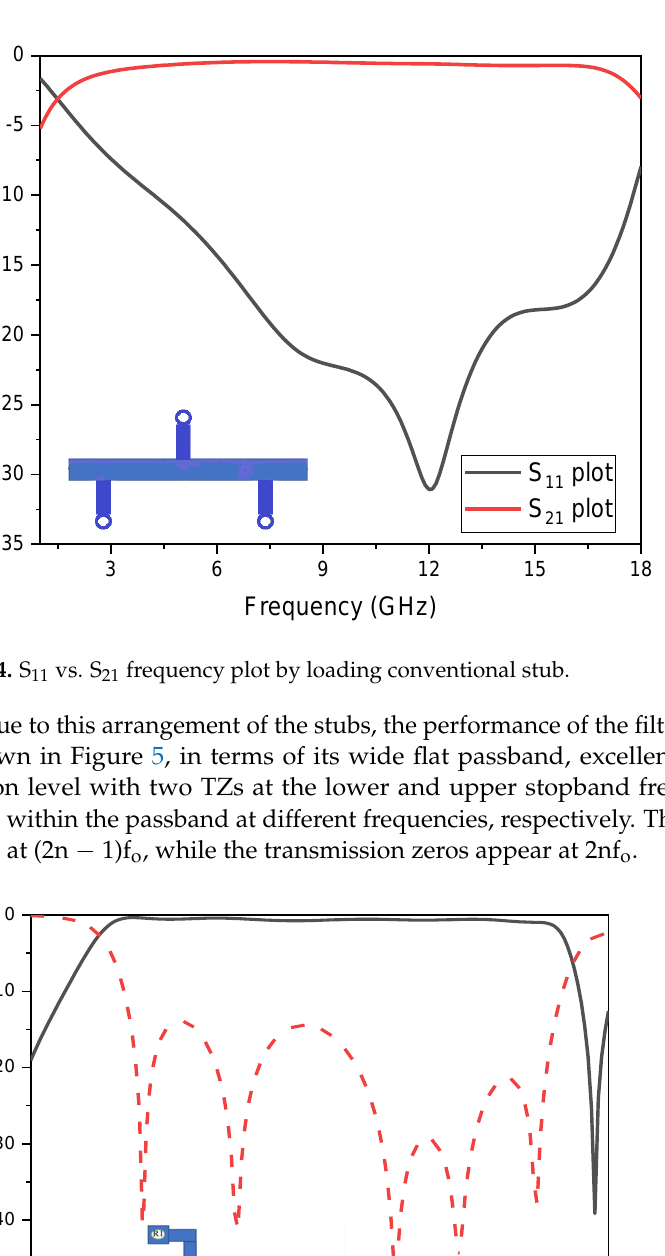
Figure 3. Stubs configurations: ( a ) open stub connected to UTL, ( b ) short-circuited stub connected to UTL, ( c ) conventional stub, and ( d ) the proposed shunt stub.